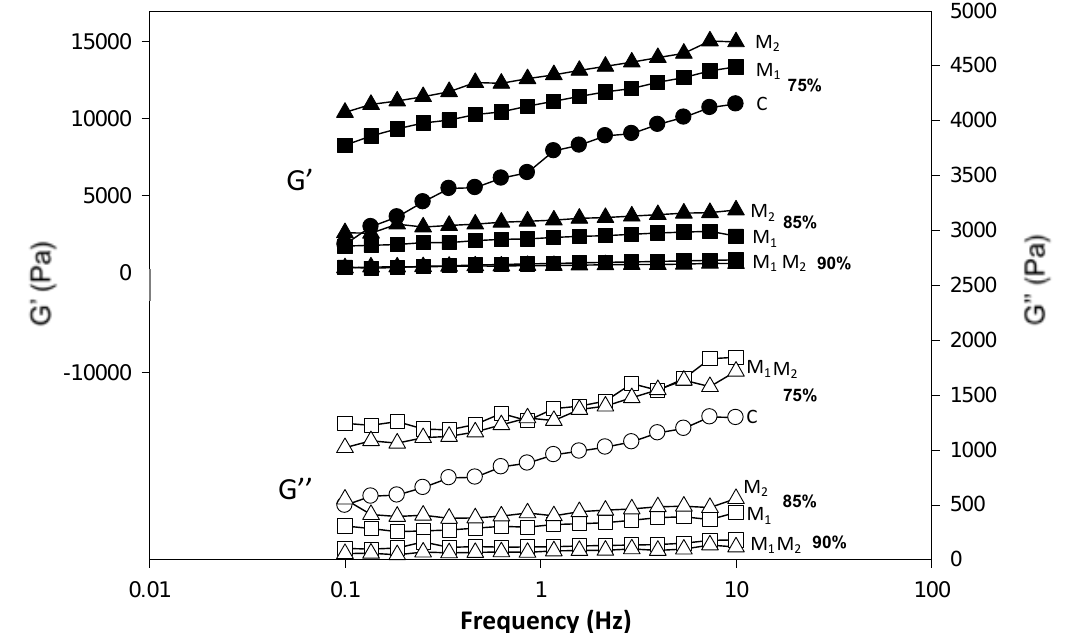
Figure 3. Frequency sweep curves of the systems formed with the three flours (circle: C, square: M 1 and triangle: M 2 ) at three different moisture contents (75%, 85% and 90%) at the hot condition (HC).